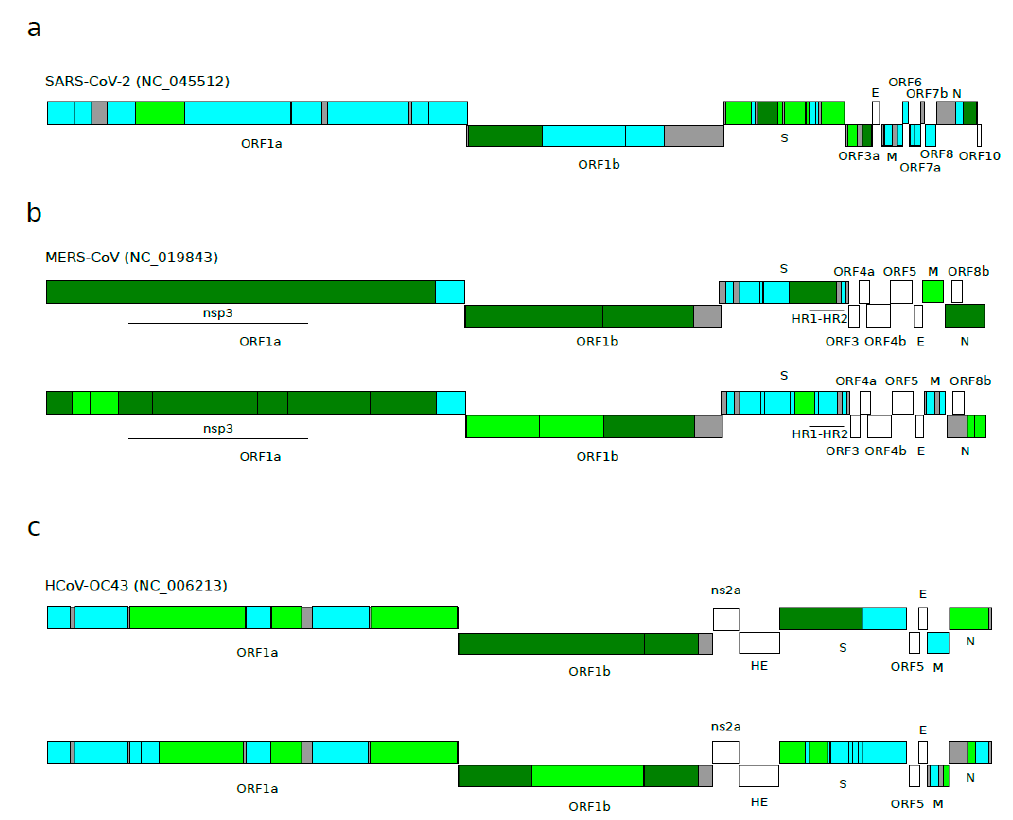
Figure 2. Episodic diversifying selection in Betacoronavirus subgenera. Schematic representation of positive selection signals detected by aBSREL in ( a ) sarbecoviruses, ( b ) merbecoviruses, and ( c ) embecoviruses. A representative viral species of each lineage was used to map ORFs and non-recombinant regions. Color codes are as follows: cyan, region analyzed with no signal of positive selection; light green, region analyzed with 1 branch of the phylogeny under positive selection; dark green, region analyzed with at least 2 branches of the phylogeny under positive selection; gray, regions not analyzed due to the presence of many breakpoint events; white, regions excluded a priori from the analyses. See methods for details regarding region selection. Merbecovirus and embecovirus alignments were divided based on their 3SEQ results (panels b and c , upper schemes), and also based on their 3SEQ results and sarbecovirus 3SEQ results (panels b and c , lower schemes) so as to obtain regions of similar lengths to in sarbecoviruses. Merbecovirus regions found under positive selection in previous studies [45,49] are also reported. HR1-HR2: heptad repeat domains 1 and 2.